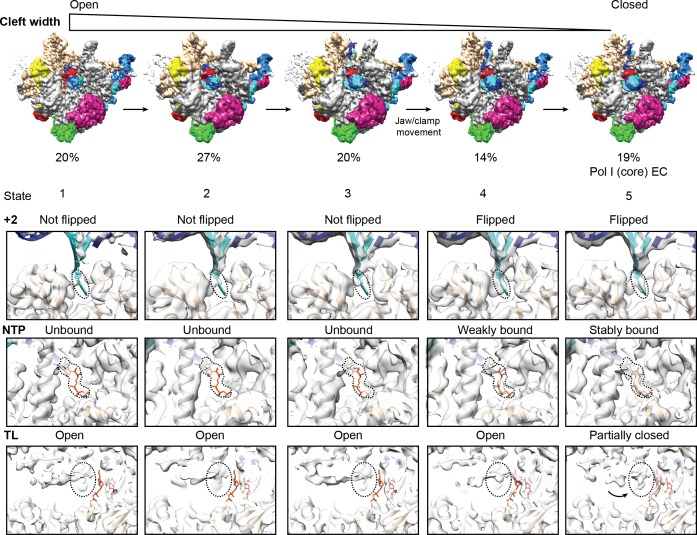
Conformational heterogeneity in the Pol I EC.Classification of the pooled Pol I EC particles reveals intermediates with slight differences in the width of the cleft, flipping of the +2 base, density for GMPCPP and trigger loop (TL). Closing of the cleft is accompanied by +2 base flipping, stronger density for GMPCPP and appearance of density for A190 L1202. Flipping of DNA base +2 occurs before complete closing of the cleft by the movement of the Jaw/clamp domains towards each other (between state 3 and 4). The transition from state 1 to 5 includes the sequential movement of the protrusion and wall domains towards the clamp, the jaw/clamp movement that induces +2 base flipping and closing of the cleft by movement of modules 1 and 2.